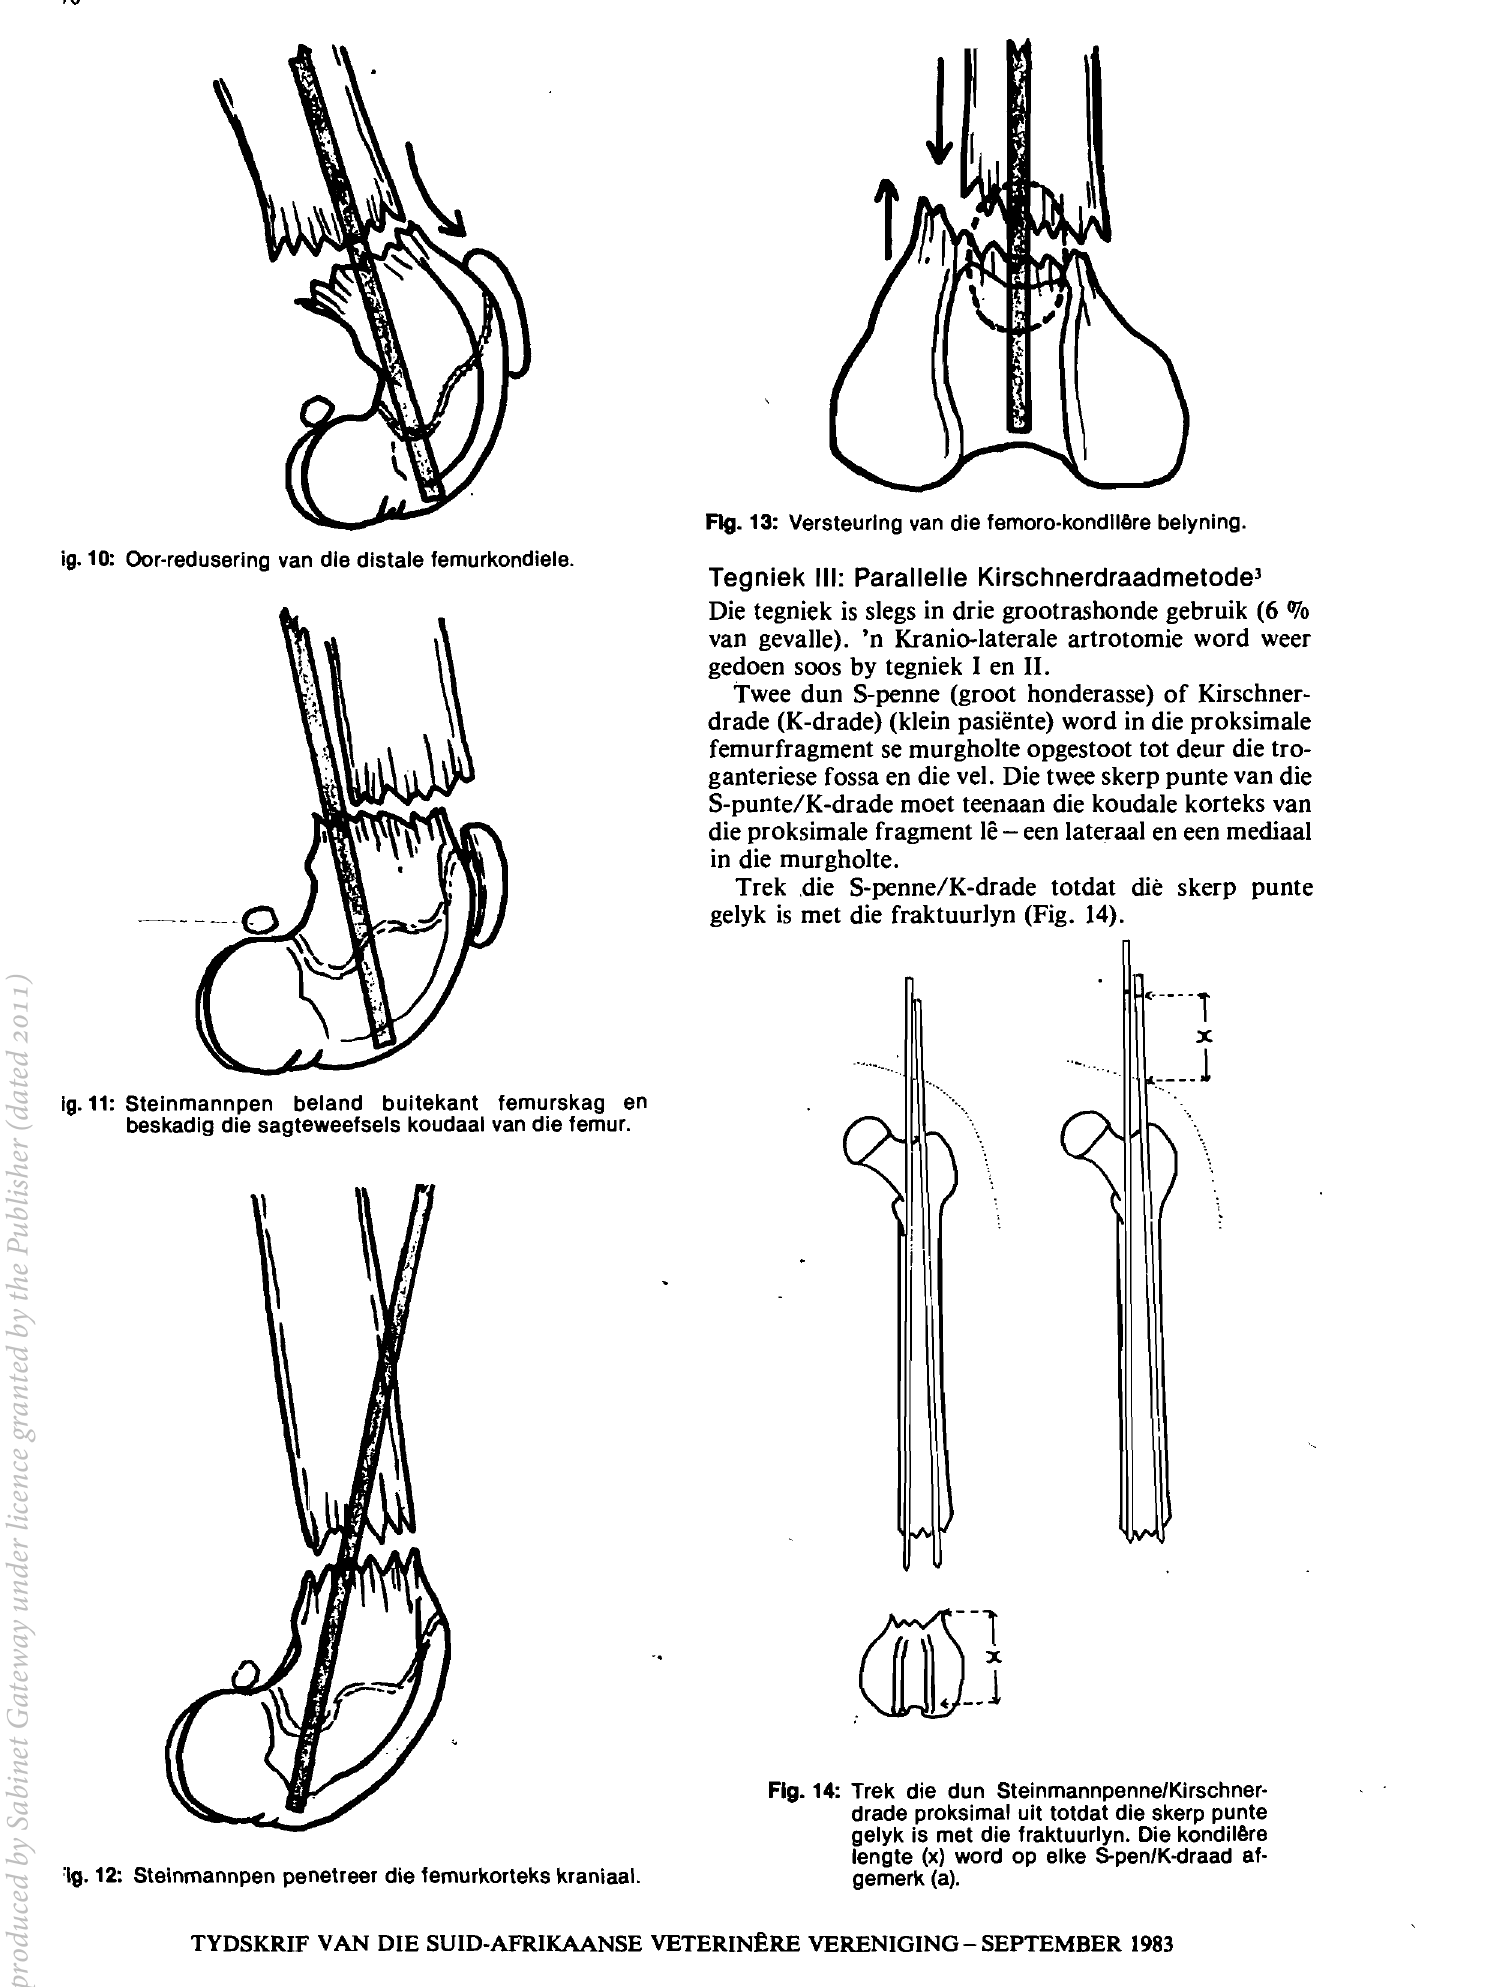
Fig. 14: Trek die dun Steinmannpenne/Kirschner drade proksimal uit totdat die skerp punte gelyk is met die fraktuurlyn. Die kondilllre lengte (x) word op elke S-pen/K-draad af gemerk